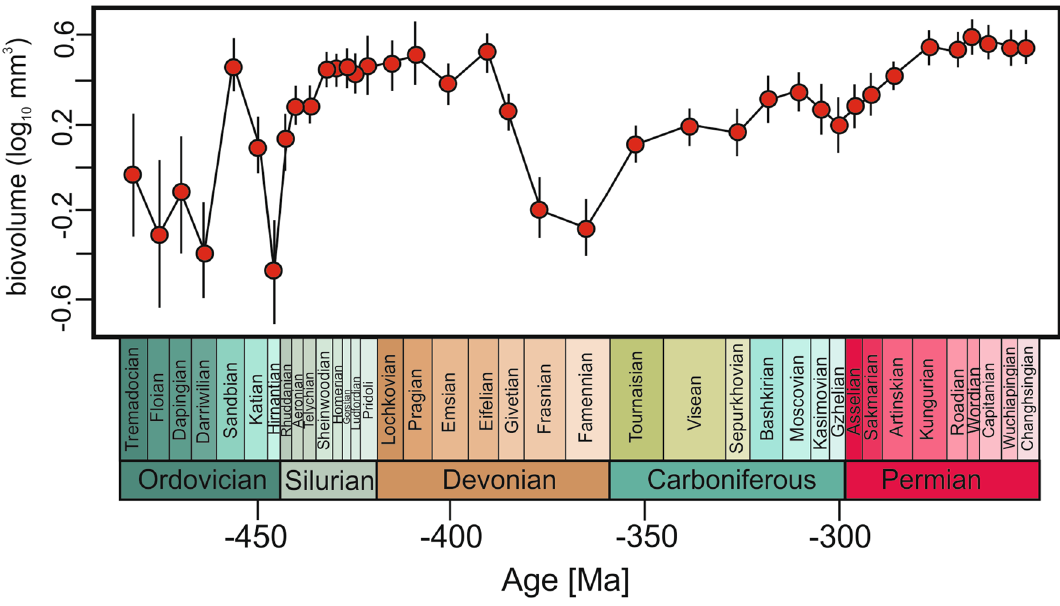
Figure 1. Trend in mean calyx size of crinoids as a whole in the Palaeozoic. Vertical lines represent error bars.